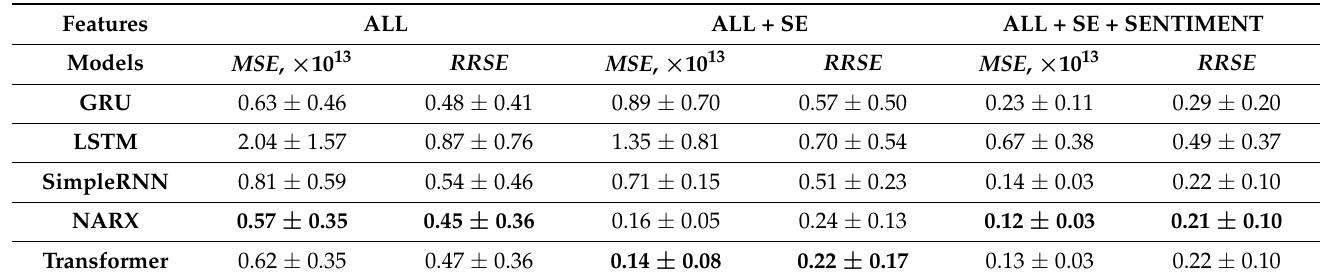
Table 5. Export prediction scores (regularization and sentiment